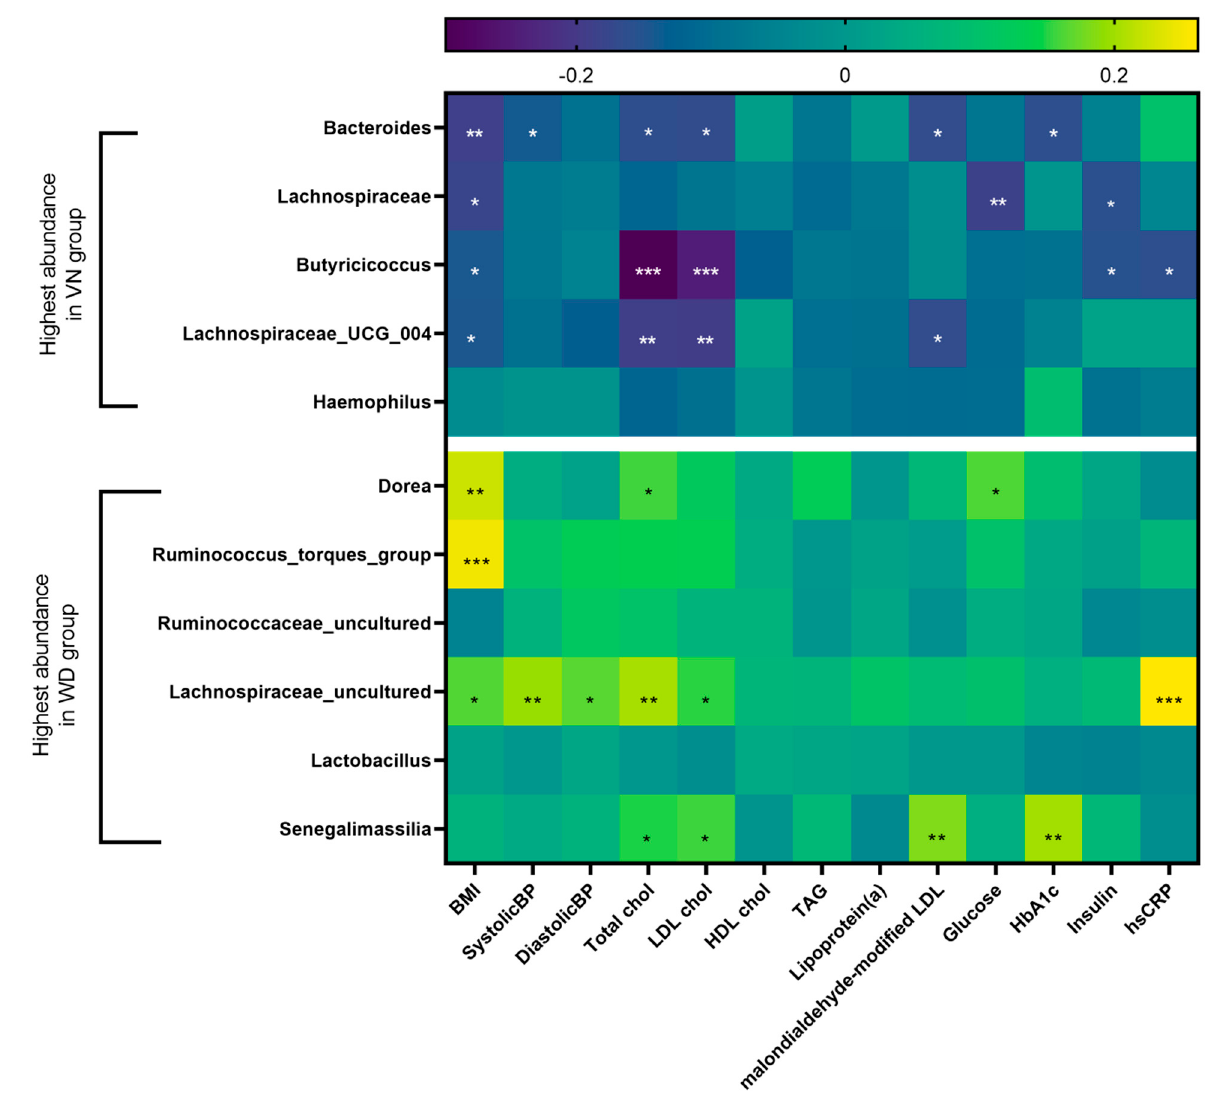
Figure 7. Heatmap of the correlation analysis of 11 significant genera, separated by maximum abun- dance in WD or VN group, resulting from the LefSe analysis of the four diets tested. Top legend represents corresponding r-values. Signi fi cant results are marked as following: *: p < 0.05, **: p < 0.01, ***: p < 0.001. BMI = body mass index; BP = blood pressure; Total chol = total cholesterol; LDL chol = low-density lipoprotein cholesterol, HDL chol = high-density lipoprotein cholesterol; TAG = triacyl- glycerides; HbA1c = hemoglobin A1c; hsCRP = high sensitivity c -reactive protein.